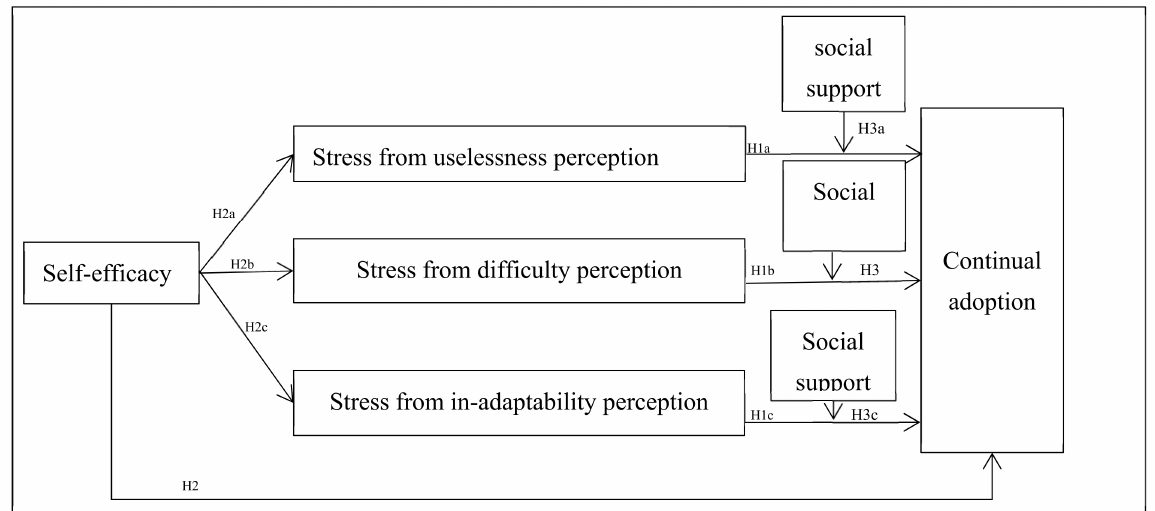
Figure 2. Hypothesis